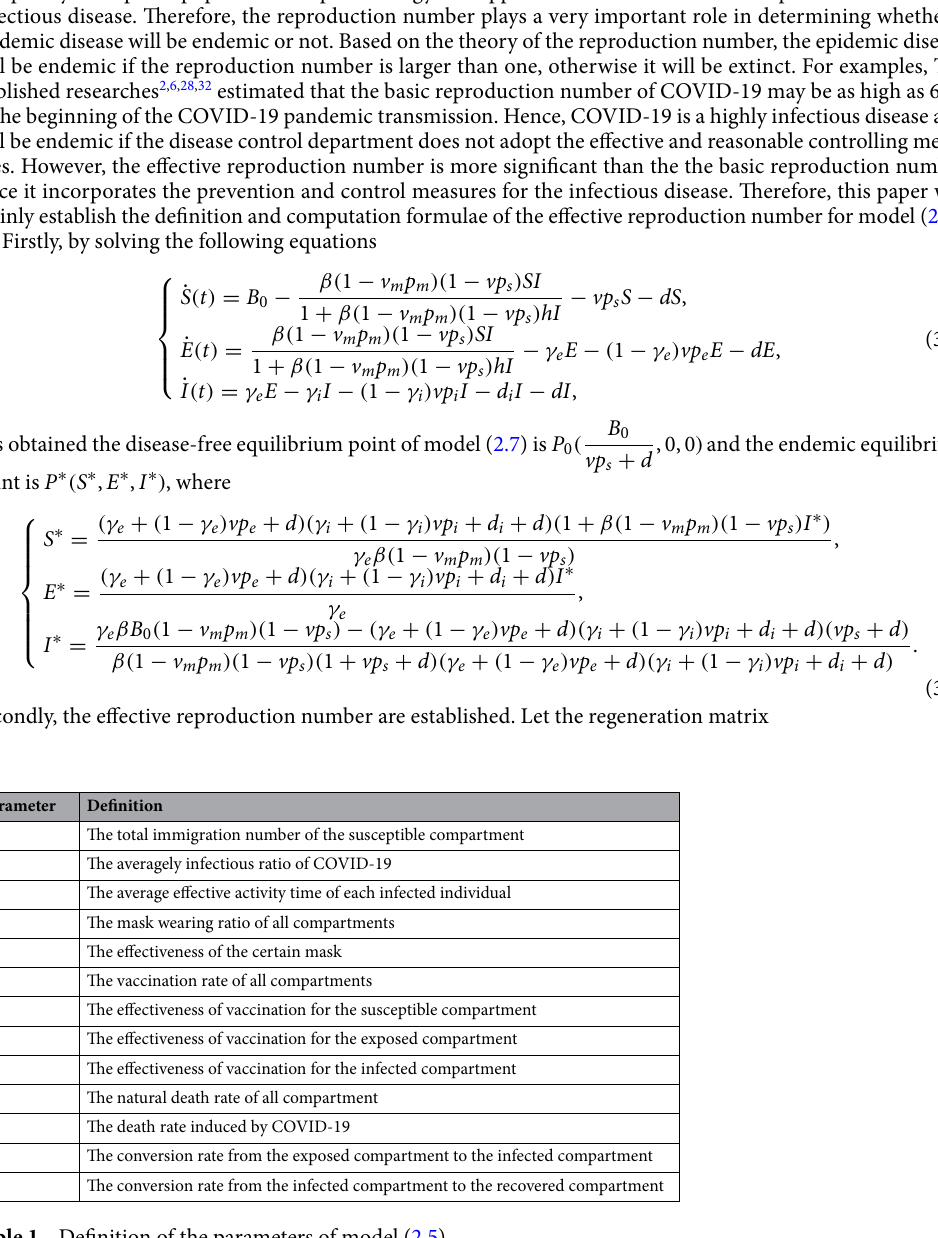
Table 1. Definition of the parameters of model